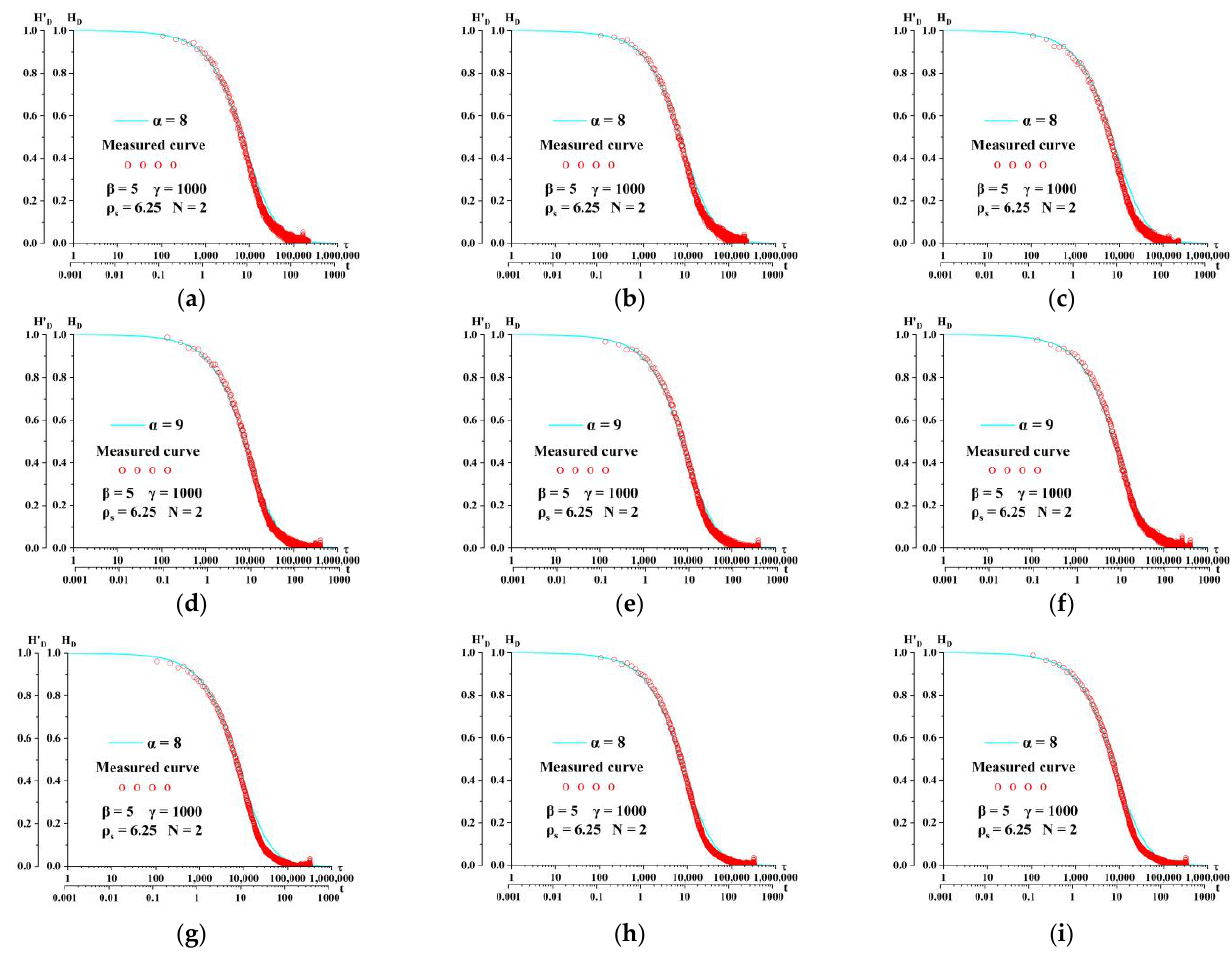
Figure 9. Curve fitting diagram between measured data from slug test and HWS model standard curve under model conditions of ρ s = 6.25. ( a ) P 20 -Sls1. ( b ) P 20 -Sls2. ( c ) P 20 -Sls3. ( d ) P 20 -Slm1. ( e ) P 20 -Slm2. ( f ) P 20 -Slm3. ( g ) P 20 -Sll1. ( h ) P 20 -Sll2. ( i ) P 20